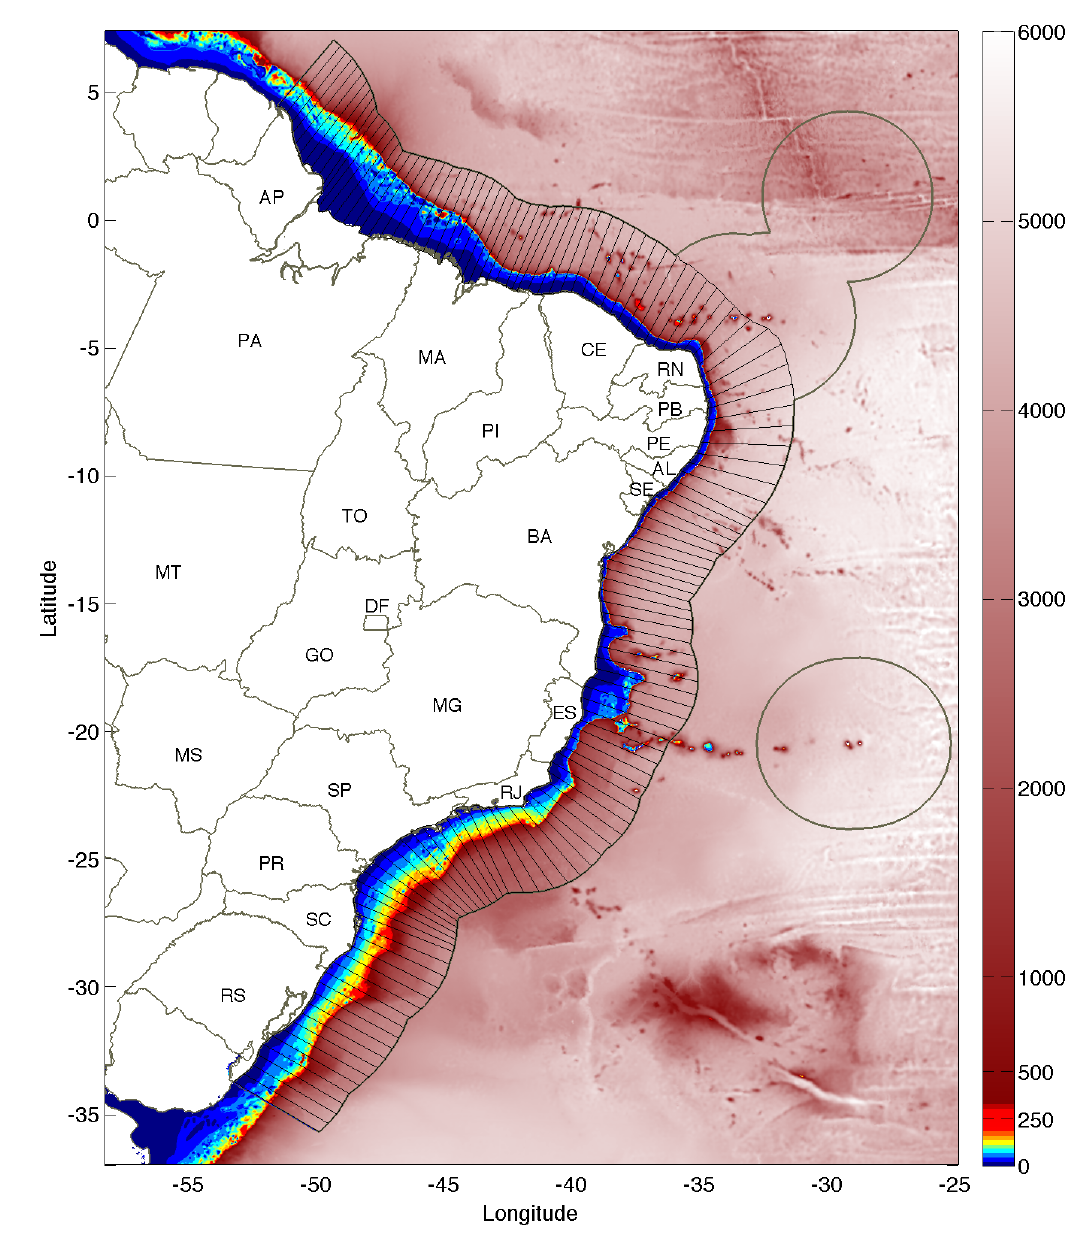
Figure 1. Study region’s bathymetry and Brazilian states. ETOPO1 depth (see Amante et al. 2009; [31]) is depicted by a color shade in meters. The thick gray line corresponds to the Exclusive Economic Zone (EEZ), while thin gray lines represent the coastal sectors defined for data processing and visualization. Coastal states are: Amapá (AP), Pará (PA), Maranhão (MA), Piauí (PI), Ceará (CE), Rio Grande do Norte (RN), Paraíba (PB), Pernambuco (PE), Alagoas (AL), Sergipe (SE), Bahía (BA), Espírito Santo (ES), Rio de Janeiro (RJ), São Paulo (SP), Paraná (PR), Santa Catarina (SC) and Rio Grande do Sul